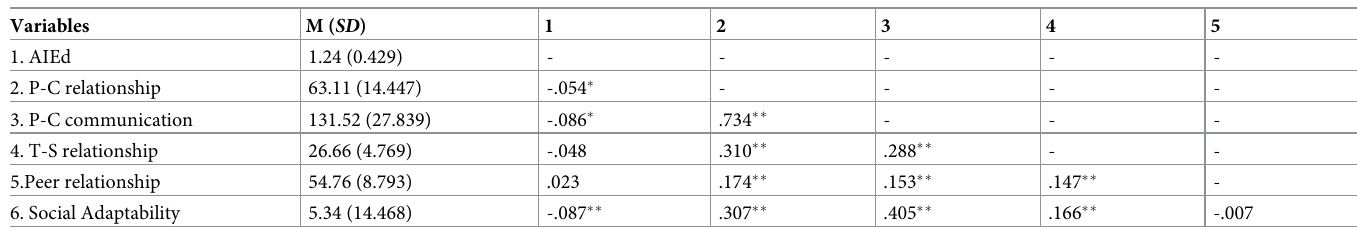
Table 2. Correlation analysis results of AIEd, social support and social adaptability.